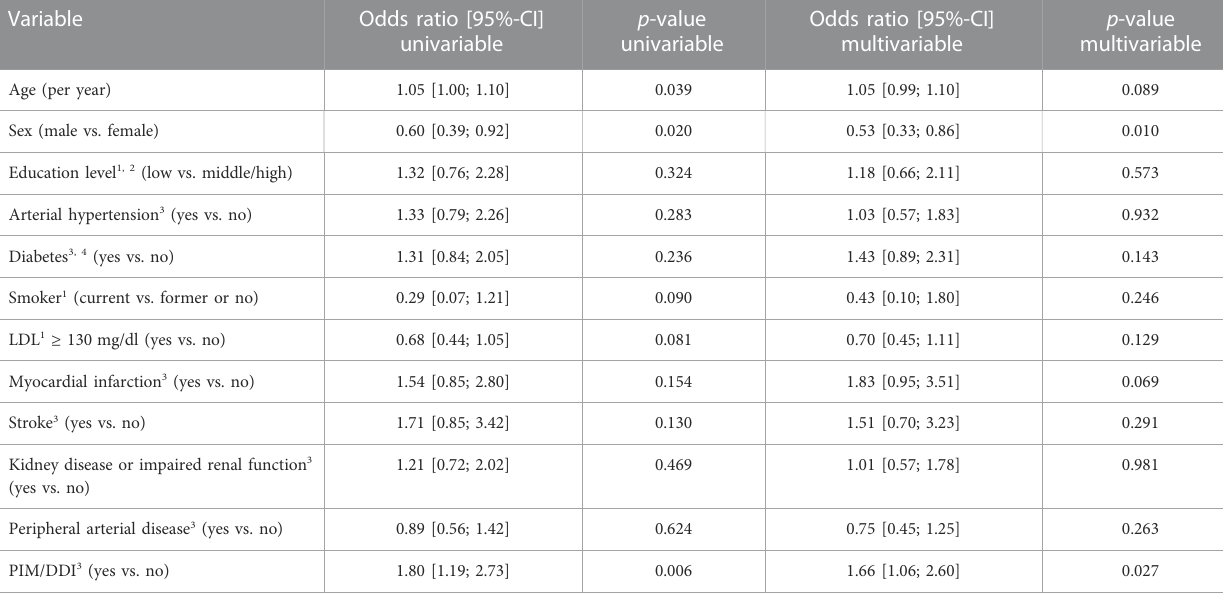
TABLE 4 Univariable models and multivariable model for the endpoint frequent falling (1,349 patients).